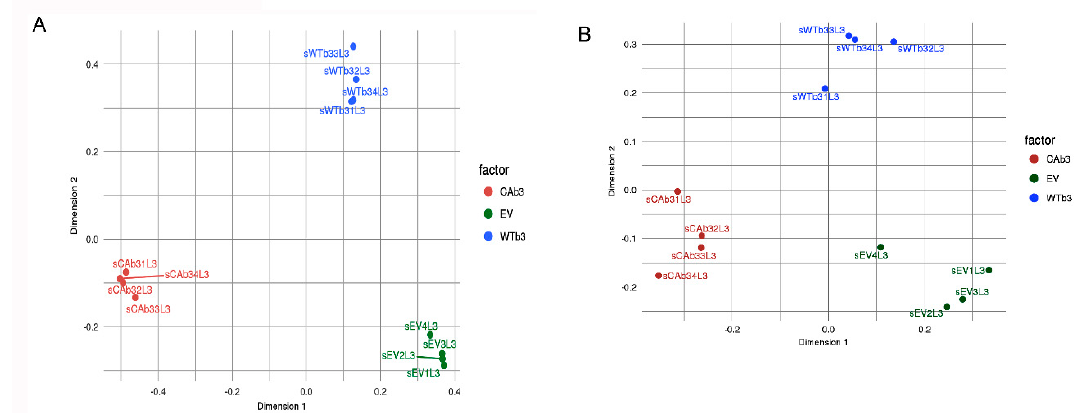
Figure 1. The EV, WT β 3-integrin and CA β 3-integrin cell lines are distinct cell populations with unique transcriptomes. Unsupervised clustering was used to verify that the cell lines used were distinct from each other. Multidimensional scaling (MDS) plots at the gene ( A ) and the transcript ( B ) level were generated. Both plots show that the greatest variation observed was between the three cell lines rather than within the individual samples of each cell line.